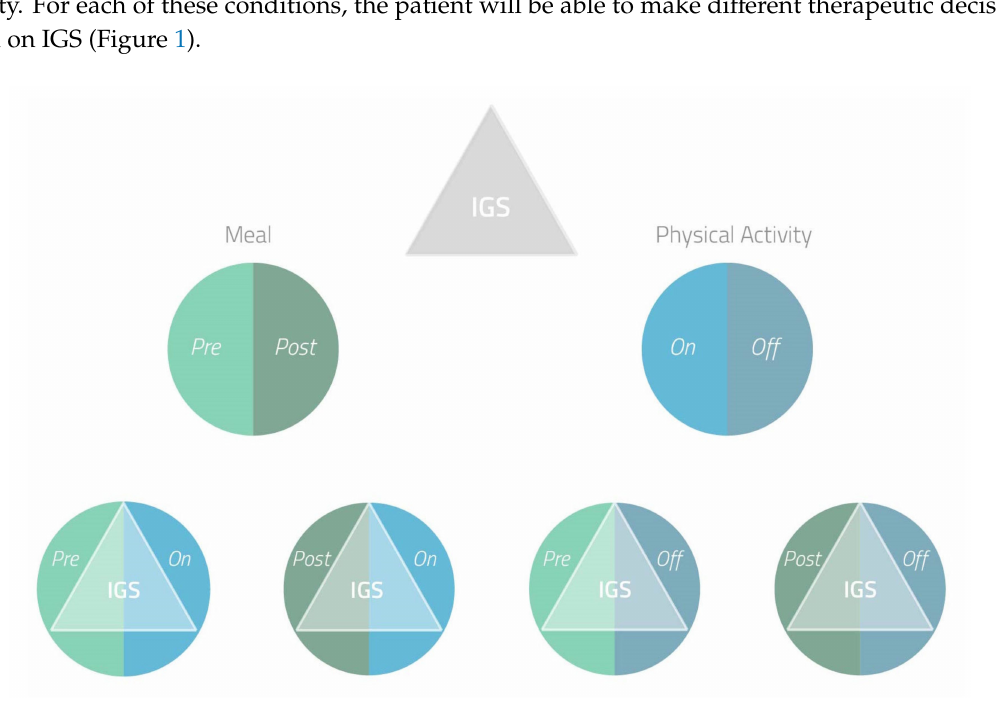
Figure 1. Integrated glycemic state (IGS) in four di ff erent conditions. IGS includes the point value of blood glucose, the trend arrow that indicates the direction and speed towards which blood glucose is moving, glucose profile of the previous hours / days. The same IGS can occur in four di ff erent conditions: pre-meal in the presence of physical activity, pre-meal in the absence of physical activity, post-meal in the presence of physical activity, post-meal in the absence of physical activity. For each condition the patient will be able to make di ff erent therapeutic decisions based on